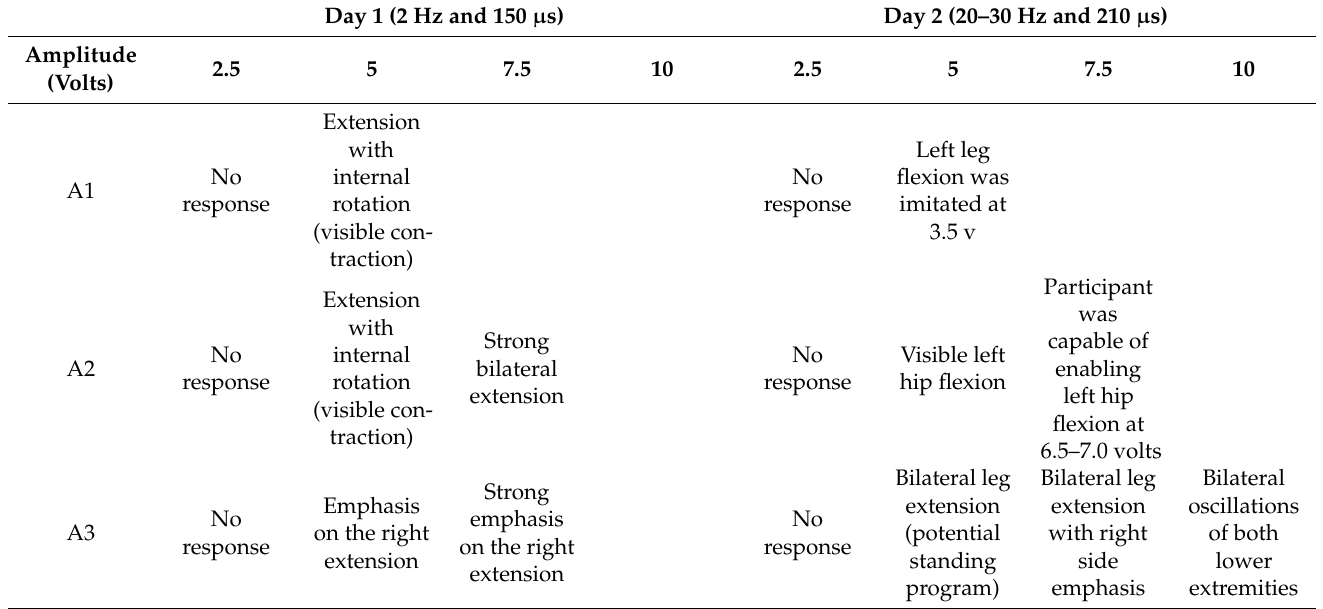
Figure 3. Configuring the percutaneous scES leads with eight contacts each using Sayenko’s approach to target bilateral knee extensor muscles in a lying position. The results of such configurations are listed in Table 1. Table 1. Sayenko’s mapping approach was adopted initially to configure the implanted leads (see Figure 3). After determining the initial responses on day 1 using 2 Hz and 150 µ s, the whole entire approach was repeated on the following day (day 2) using 20–30